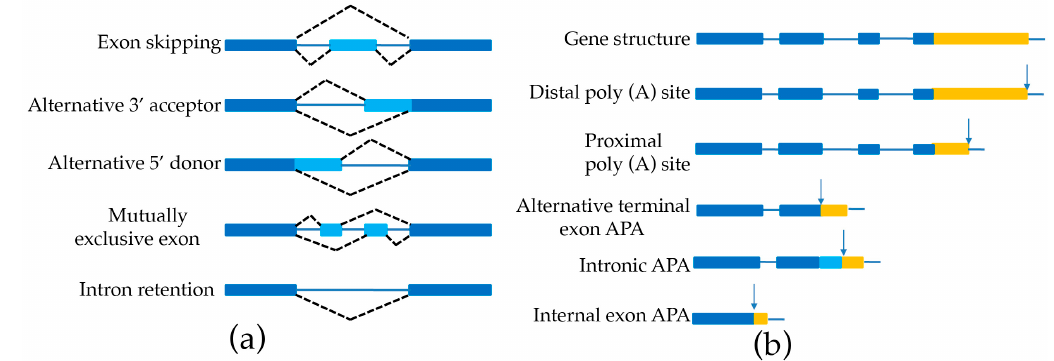
Figure 3. Schematic representation of alternative splicing (AS) and alternative polyadenylation (APA). ( a ) Shows alternative splicing; ( b ) shows alternative polyadenylation. The first two APA types—which both are termed as tandem 3 ′ untranslated region (UTR) APA—generate multiple isoforms that differ in their 3 ′ UTR length without impacting the protein sequence encoded by the gene. The other three APA types potentially affect the coding sequences: alternative terminal exon APA, in which APA generates isoforms that differ in their last exon; intronic APA, which involves cleaving at the cryptic intronic polyA signal (PAS) with an extending terminal exon; and internal exon APA, which involves premature within one coding region with PAS. The filled dark blue boxes denote the retaining exons, and the filled light blue boxes denote the alternative exons. The blue solid lines represent introns. The black dash lines represent AS events. The filled yellow boxes represent 3 ′ UTR with different length, and the arrows denote PAS.